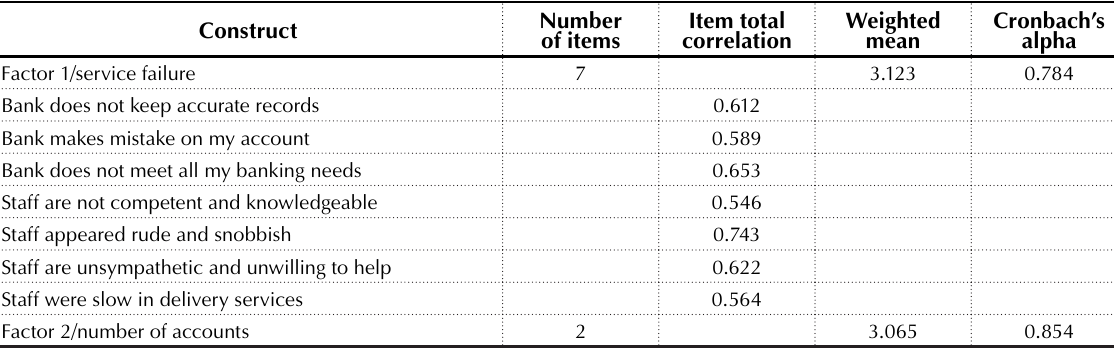
Table 2. Internal consistency of